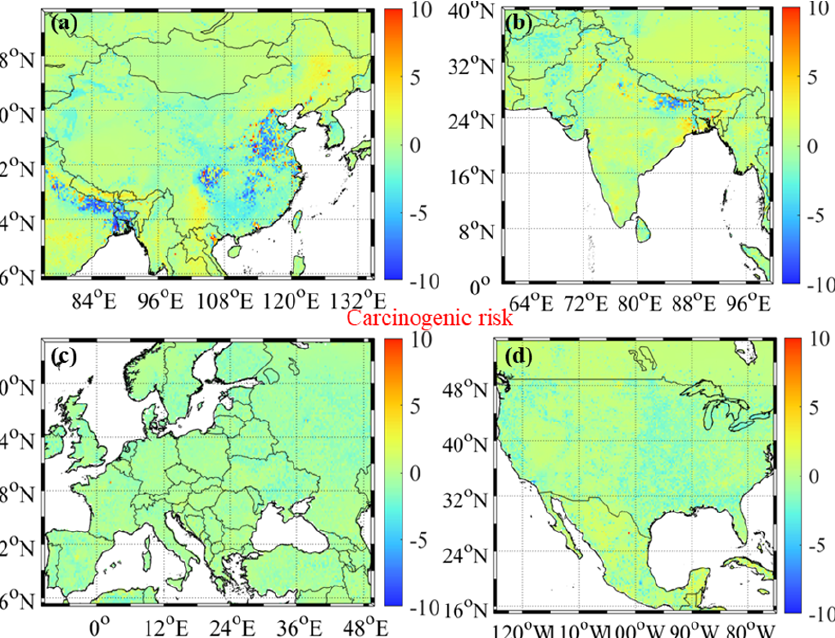
Figure 5. The carcinogenic risk differences (unit: 10 − 7 ) for atmospheric benzene between the COVID-19 period in 2020 and the same period in 2019 in (a) East Asia, (b) South Asia, (c) Europe, and (d) North America (difference = benzene concentration in 2020 − benzene concentration in